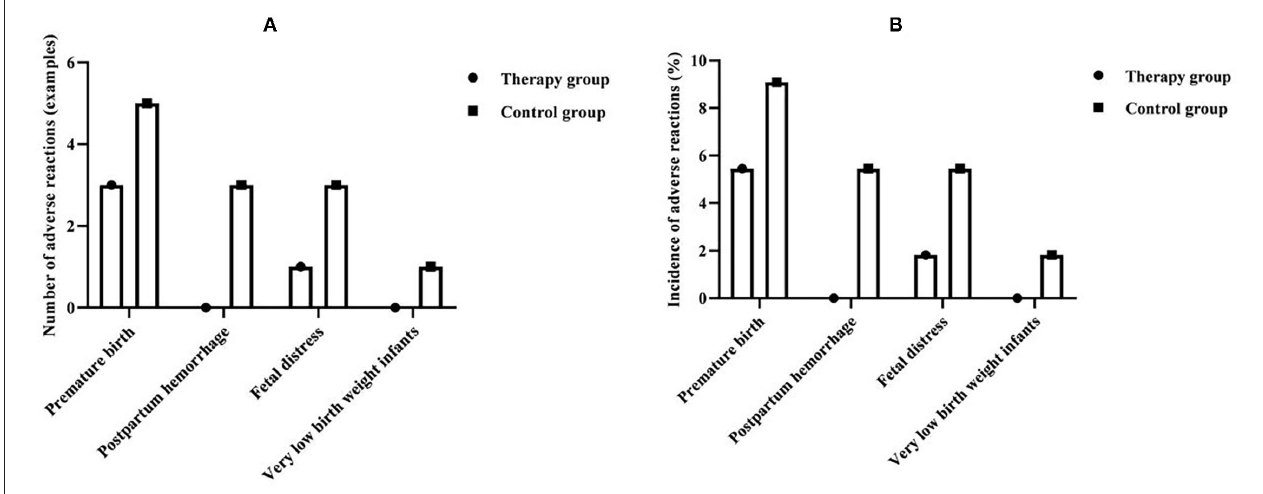
FIGURE 6 | Comparison of adverse reactions between the two groups. (A) Comparison of the number of adverse reactions between the two groups. (B) Comparison of the incidence of adverse reactions between the two